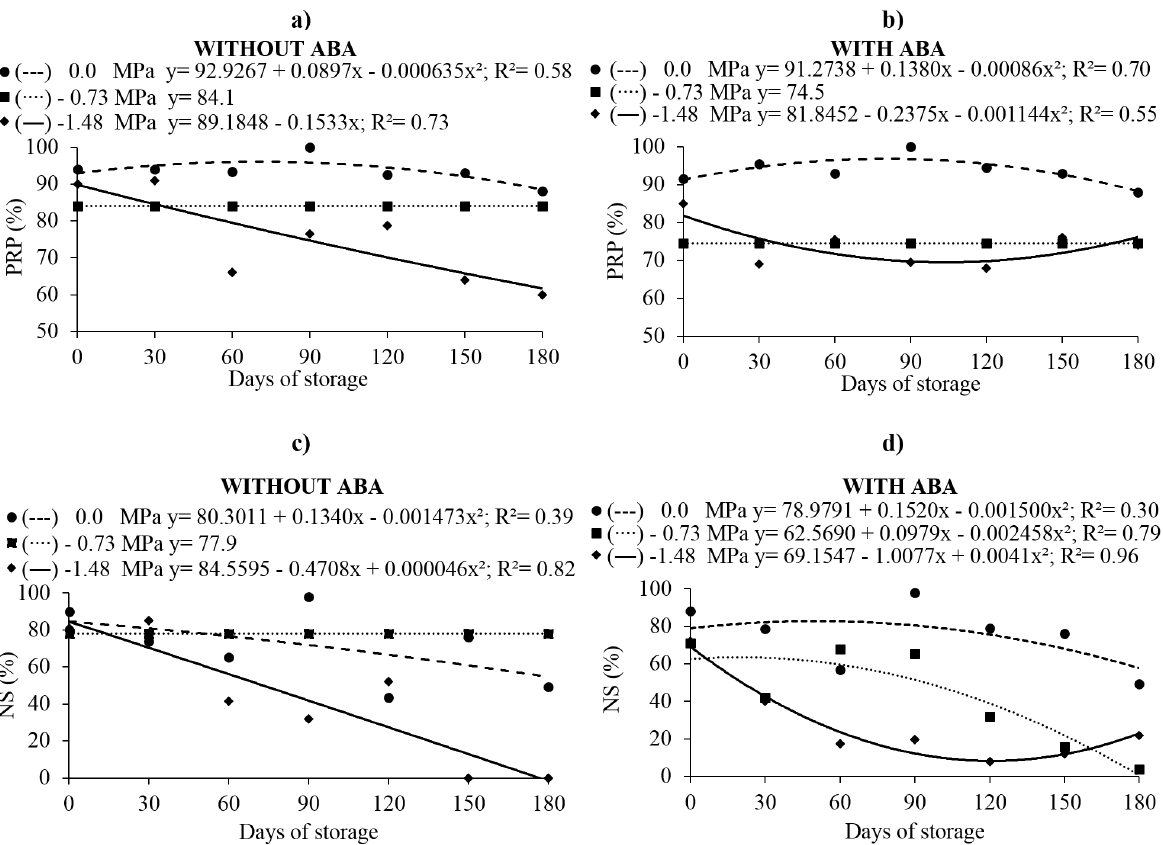
Figure 4 - Primary root protrusion - PRP % ( a , b ) and normal seedlings NS % ( c , d ) of A. edulis from seeds previously submitted to osmotic treatment with polyethylene glycol (PEG) in the potential of -0.73 and -1.48 MPa, associated or not with abscisic acid (ABA) and subsequently stored for different